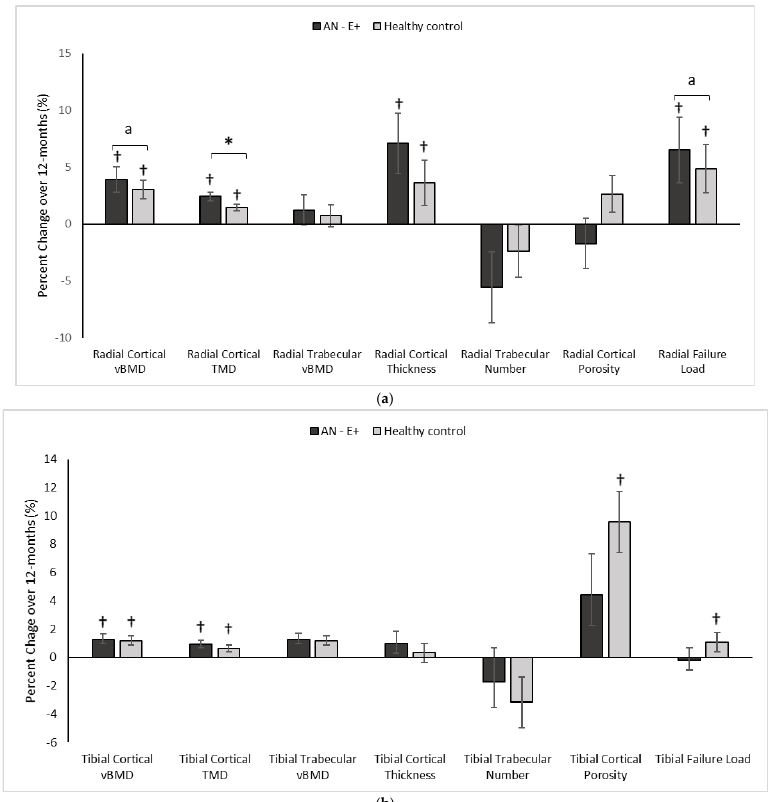
Figure 2. ( a ) Percent change in Radial HRpQCT parameters in the AN-E+ and healthy control groups over 12-months, * p < 0.05 for between group comparison after adjusting for age and race, a p < 0.05 for between group comparisons on log conversion for right skew of data distribution, † p < 0.05 for within group change. ( b ) Percent change in Tibial HRpQCT parameters in the AN-E+ and healthy control groups over 12-months, * p < 0.05 for between group comparison after adjusting for age and race, † p < 0.05 for within group change. TMD: Tissue mineral density. a indicates p < 0.05 for be- tween group comparisons on log conversion for right skew of data distribution.